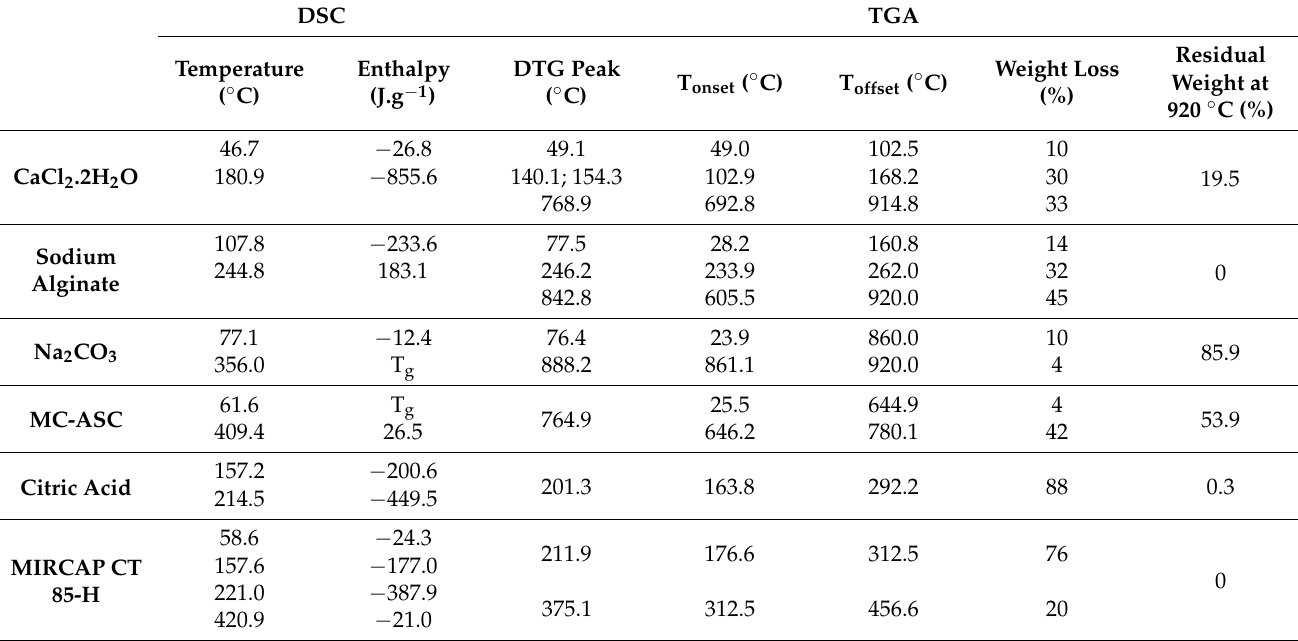
Table 2. DSC and TGA values of the compounds used in the production of neutralizing